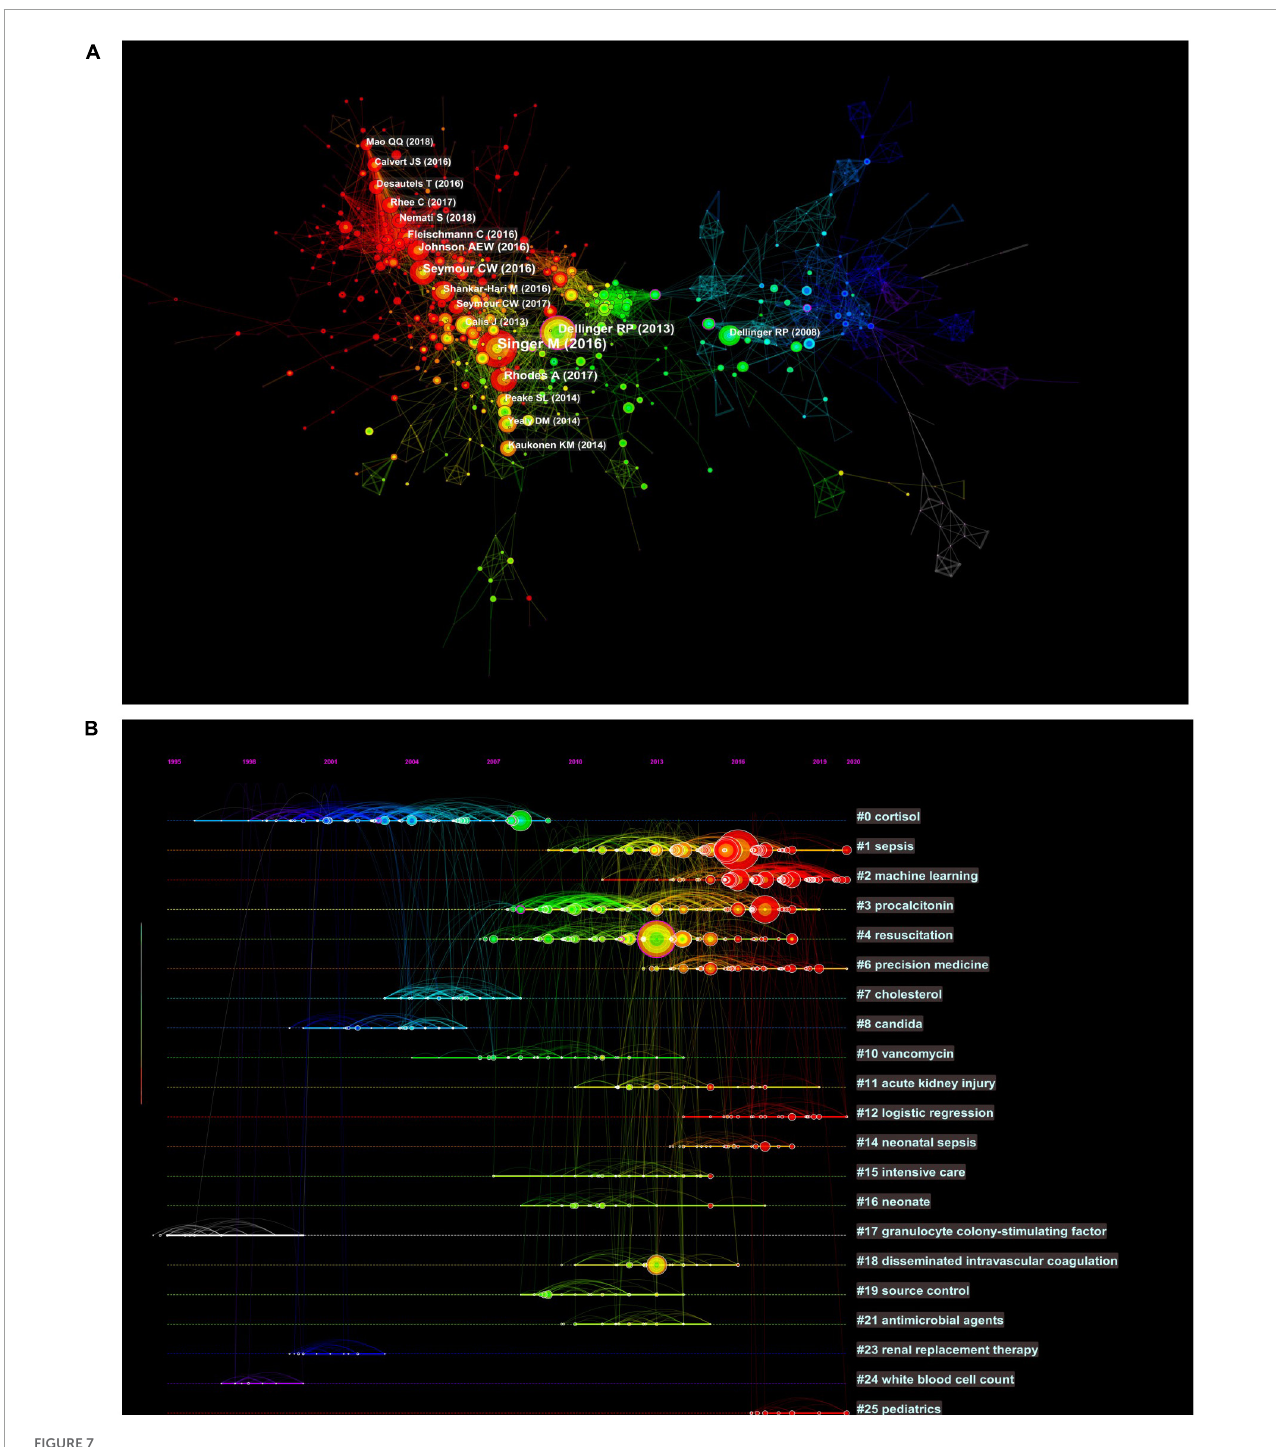
FIGURE7 Co-citation network and timeline view of references cited by publications about artificial intelligence to sepsis. (A) References co-citation network. Circle node represents reference; the line between the nodes indicates the frequency of the two references being cited at the same time. (B) Timeline view of references. Each horizontal line represents a cluster; the circular nodes on the line represent the top three most cited references in this time slice. The timeline is shown at the top of the figure, and the year corresponding to the node is its publication time. Link between nodes represents the co-citation